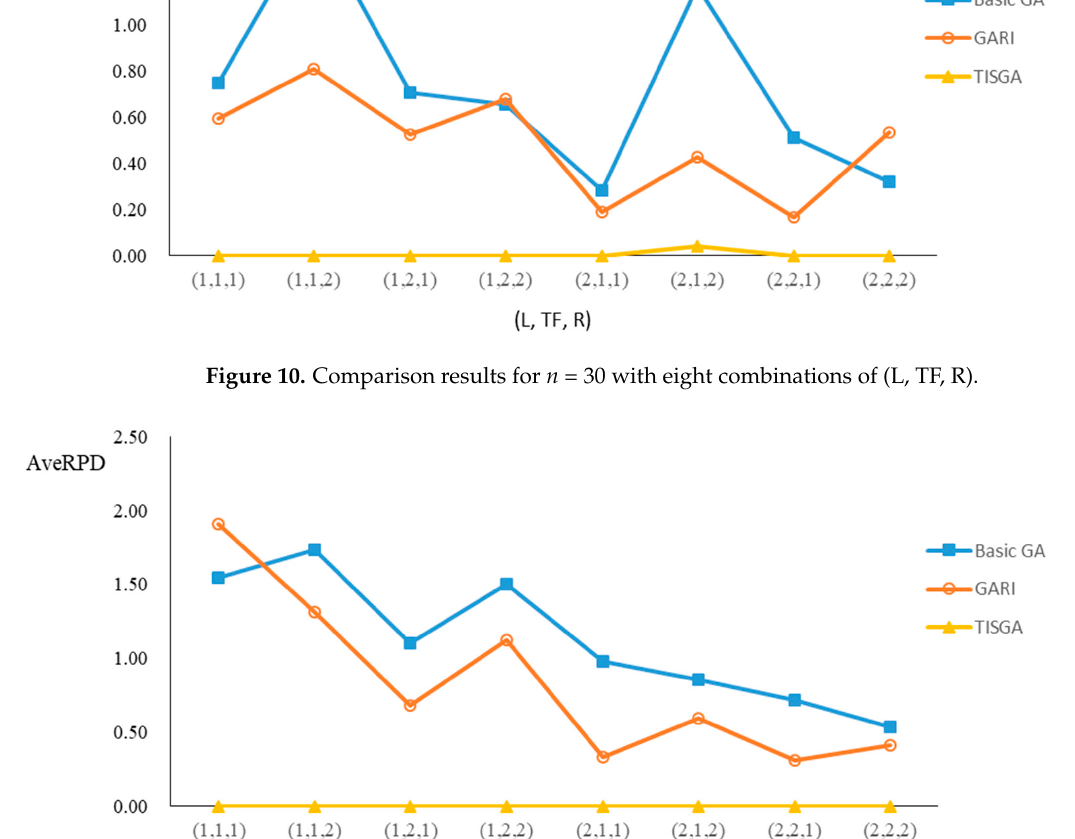
Figure 11. Comparison results for n = 35 with eight combinations of (L, TF, R).